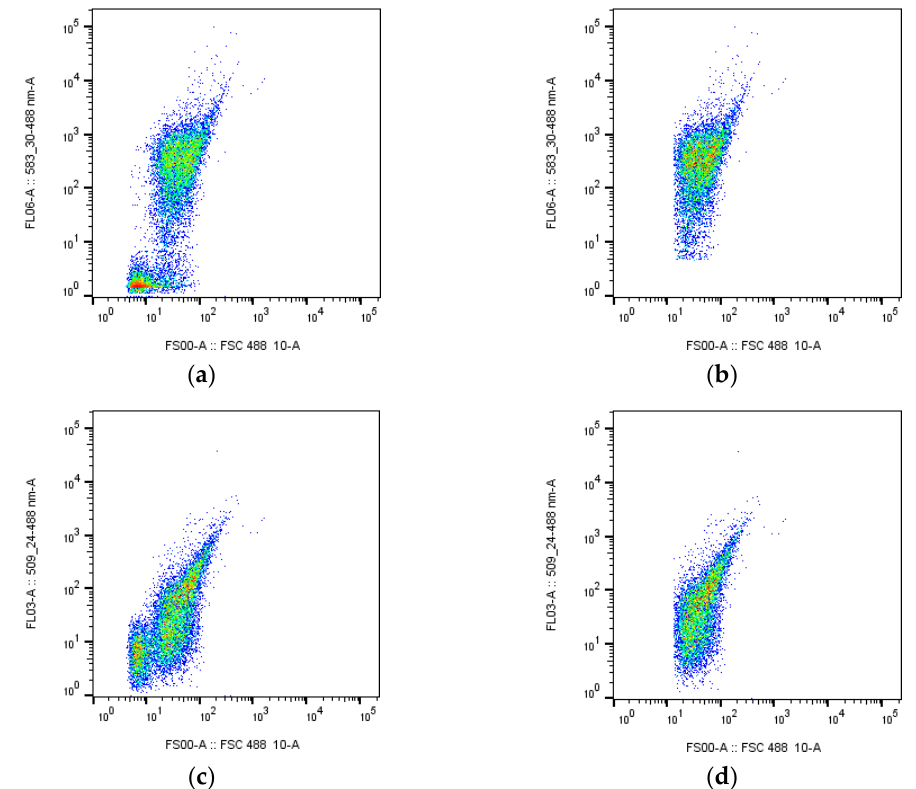
Figure 10. Flow cytometric analysis of environmental seawater samples spiked with self-fluorescence PS, where ( a ) raw emission filter at 583 nm vs. FSC at 488 nm; ( b ) emission filter at 583 nm vs. FSC at 488 nm after gating; ( c ) raw emission filter at 509 nm vs. FSC at 488 nm; and ( d ) emission filter at 509 nm vs. FSC at 488 nm after gating.